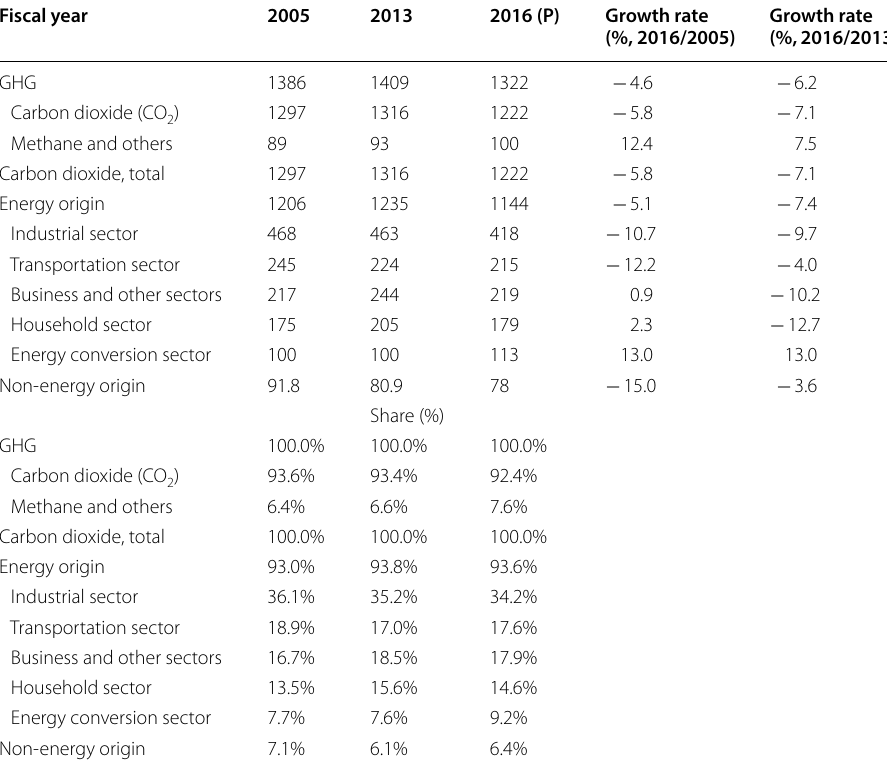
Table 1 Greenhouse gas emissions and sectoral CO equivalent) Source : Ministry of Environment